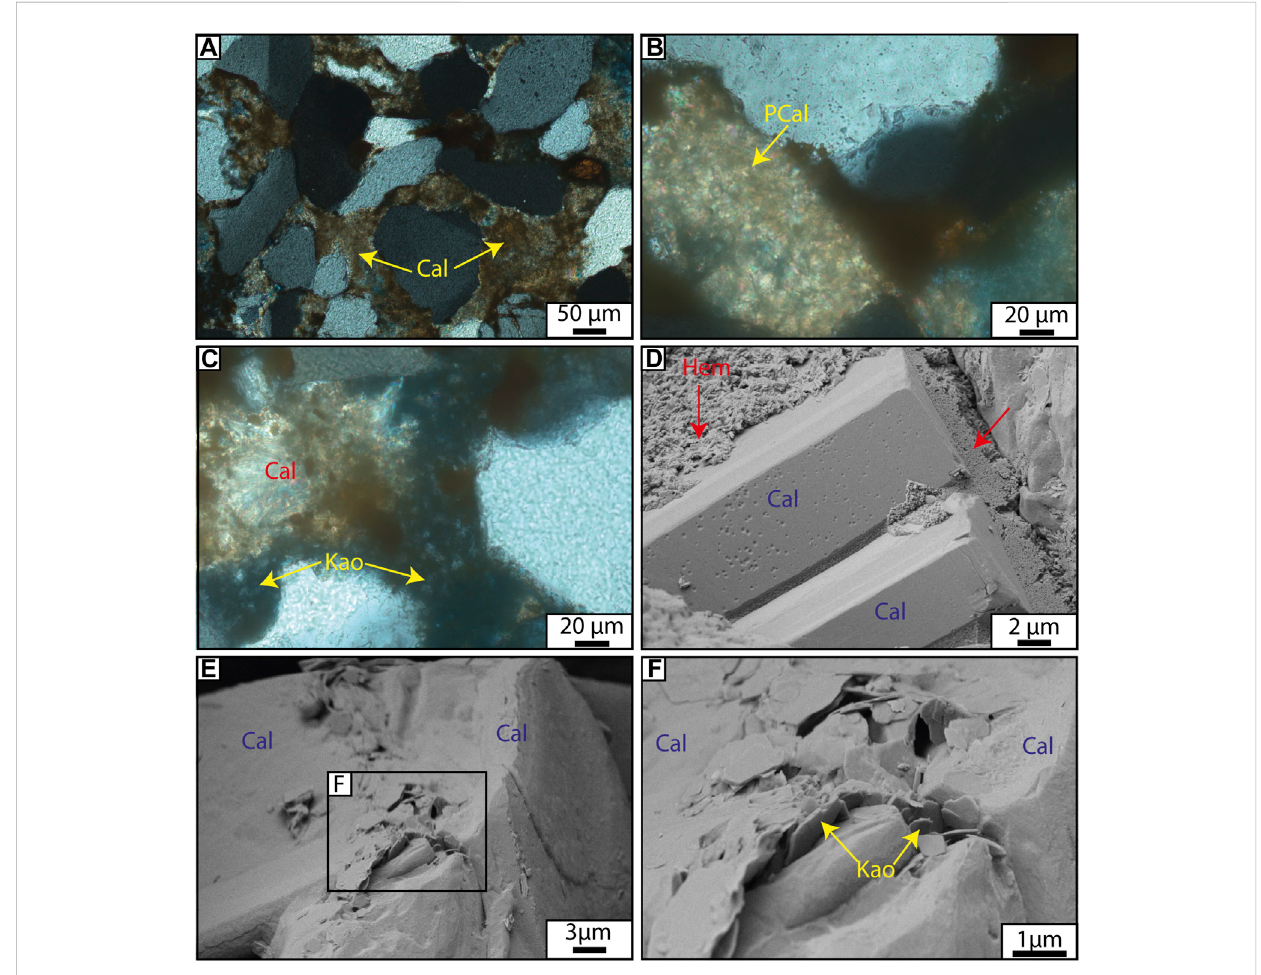
FIGURE 13 Petrographic relationship between calcite and other minerals. (A) Calcite (Cal) occurring between fl oating grains. (B) Poikilotopic calcite (PCal) blocking intergranular porosity. (C) Kaolinite (Kao) engul fi ng early-stage calcite. (D) Hematite (Hem) engul fi ng early-stage calcite. (E) Late-stage calcite (Cal) engul fi ng kaolinite (Kao). (F) Close-up image of (E) showing late-stage calcite (Cal) engul fi ng kaolinite